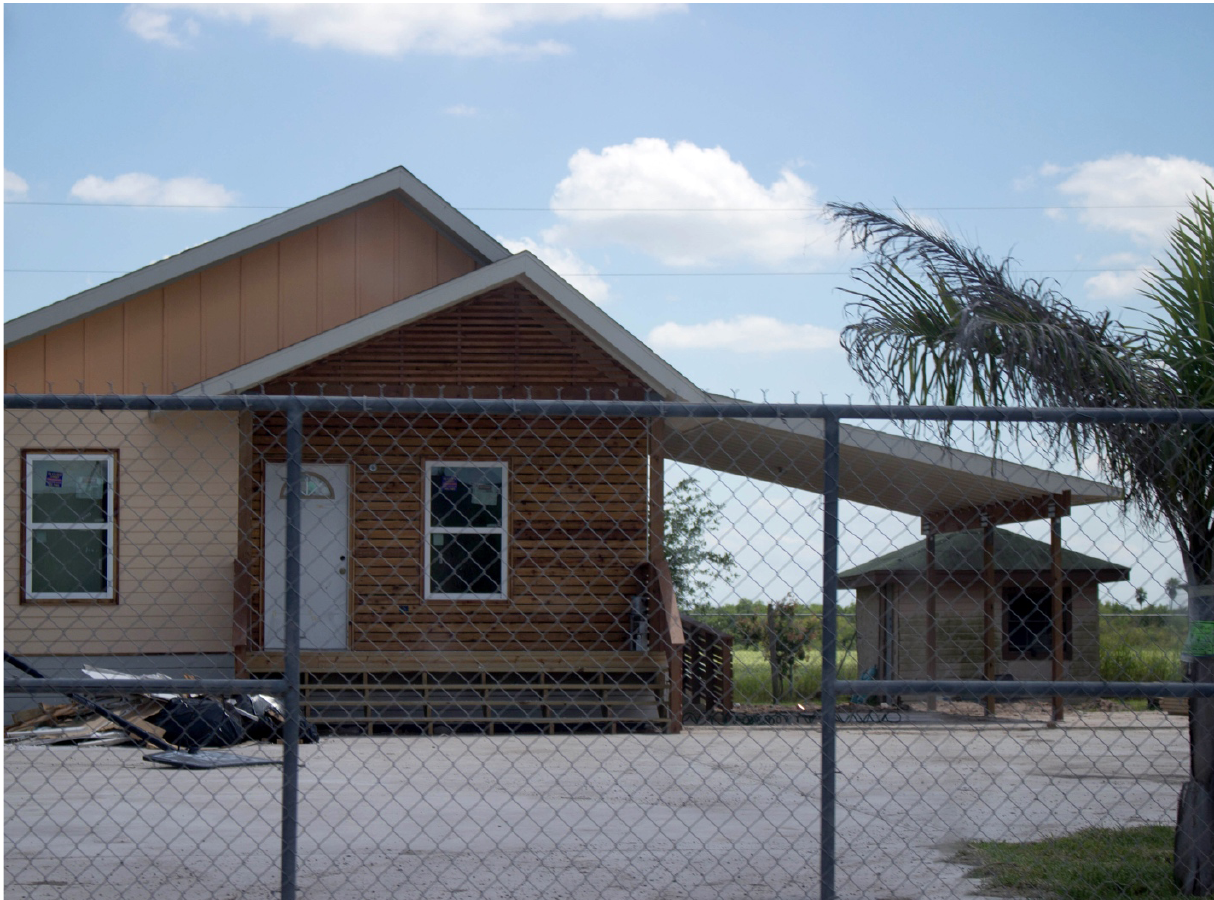
Figure 3. Nearly completed RAPIDO prototype home, designed using a sustainABLEhouse model, under construction in a colonia north of Weslaco, Texas. Source: Author